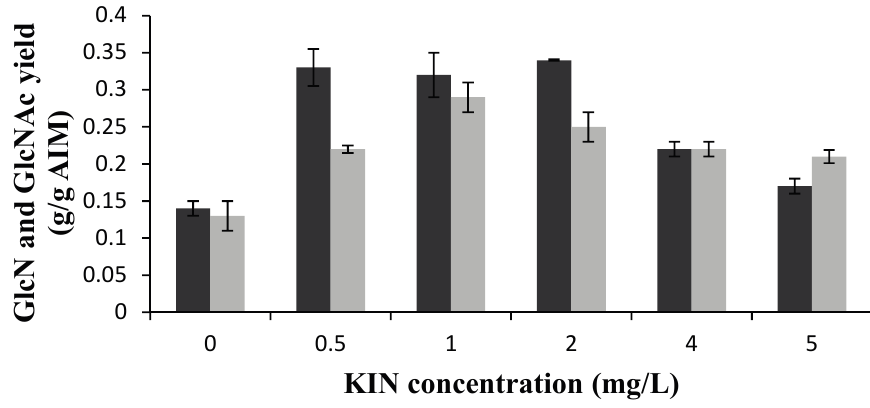
Figure 2. Effects of different concentrations of kinetin (KIN) (mg/L) on GlcN (black bars) and GlcNAc (gray bars) yields. Error bars represent the standard deviations of values obtained from at least two independent